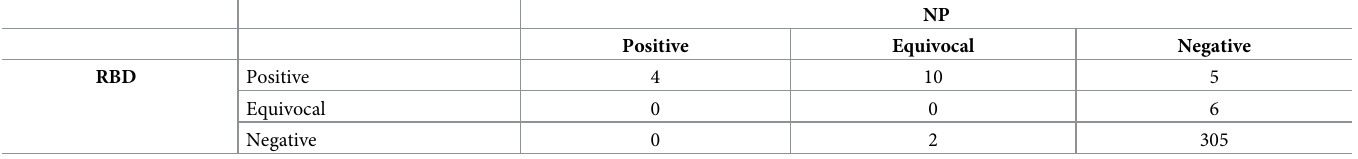
Table 4. Serum samples from healthy volunteers (n = 332) were tested for NP and RBD-specific IgG antibodies using the COVID-19 multiplex assay.